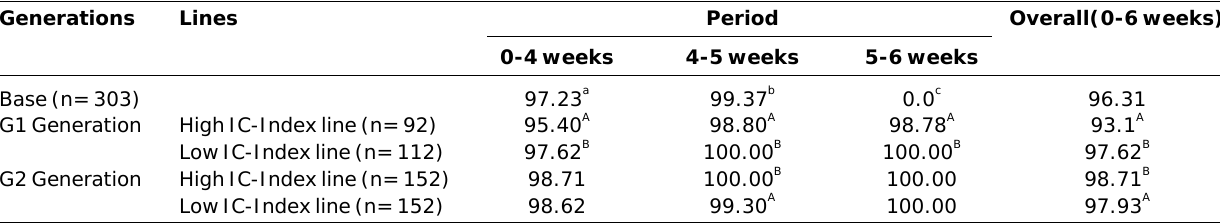
Table-1. Percent survival rate in SDL of broiler chicken up to 6 weeks of age in base population and high and low IC-index lines over two generations of divergent selection based on IC-index